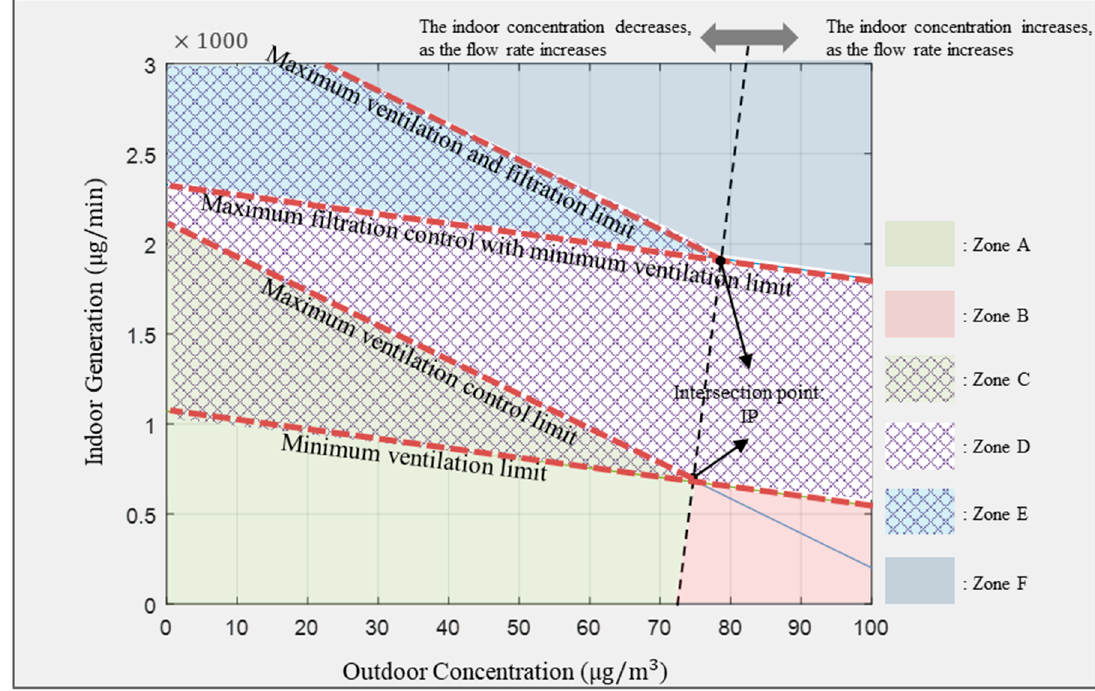
Figure 5. Control limit (CL) curve.